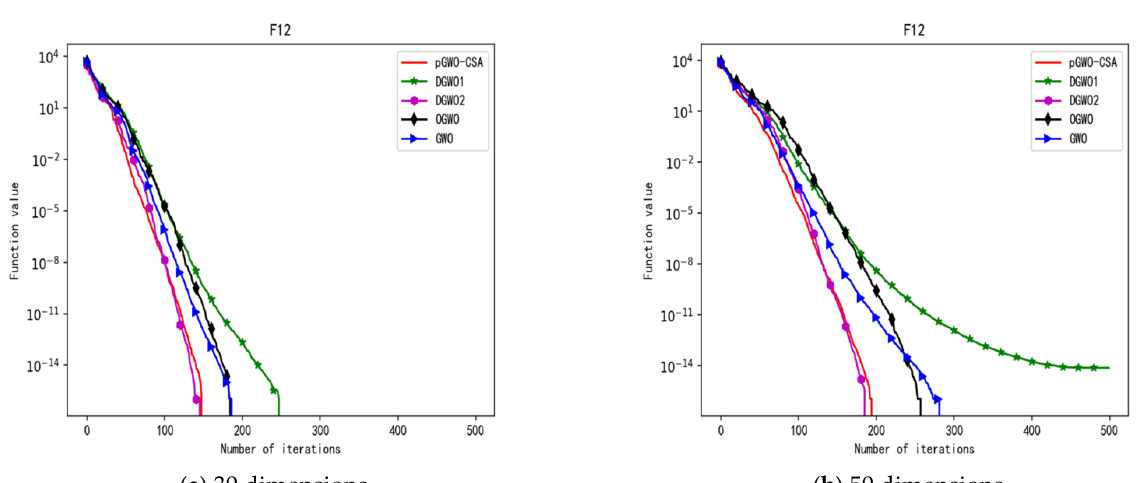
Figure 31. Convergence curve of test function F12.